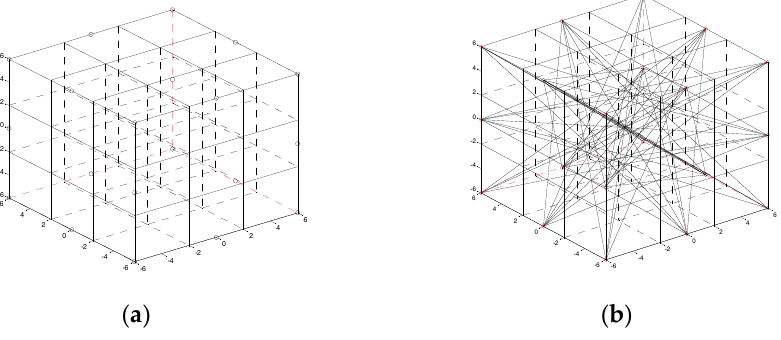
Figure 2. Illustration of the transducer arrangement and the rays. ( a ) Transducers arrangement; ( b ) Sound rays between transducers.